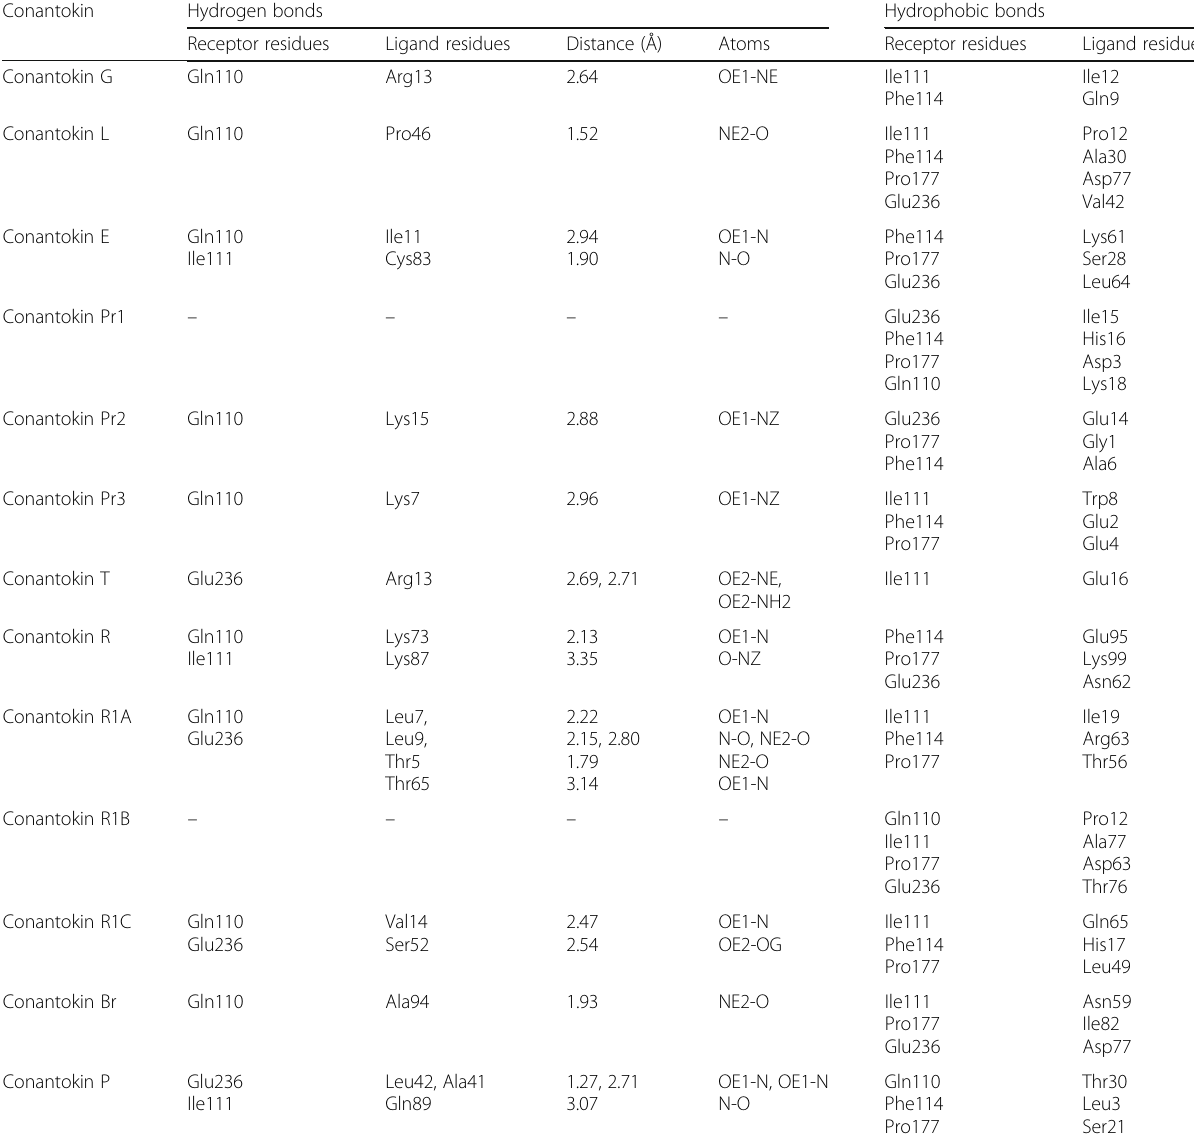
Table 3 Docking results of conantokin ligands in complex with NMDA receptor in rats